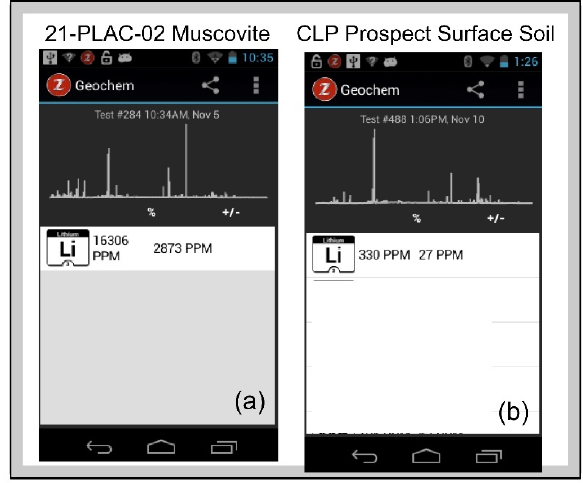
Figure 13. Screen shots from the Z-300 Geochem mode for a muscovite from Carolina Lithium Project prospect pegmatite outcrop sample 21-PLAC-02 ( a ) and a surface exposure of the Cecil soil on the CLP prospect ( b ). The Z-300 screenshots show the broadband LIBS spectrum recorded for each sample and estimated elemental abundances derived from the spectral emission line intensities. The Li content for the muscovite was determined from the mica calibration of Figure 11, whereas that for the Cecil soil was determined from the pegmatite powder calibration of Figure 12. Table 2. Comparison of measured Li contents (wt. %) for pegmatite powders from the Kleiber Oy Li deposit, Finland with estimates using the CLP pegmatite powder calibration.